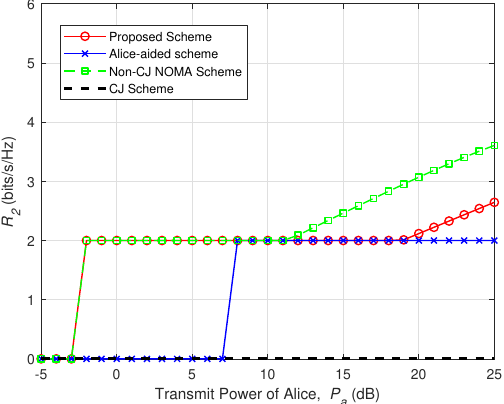
Figure 3. Transmission rate R 2 vs. the transmit power of Alice P a .